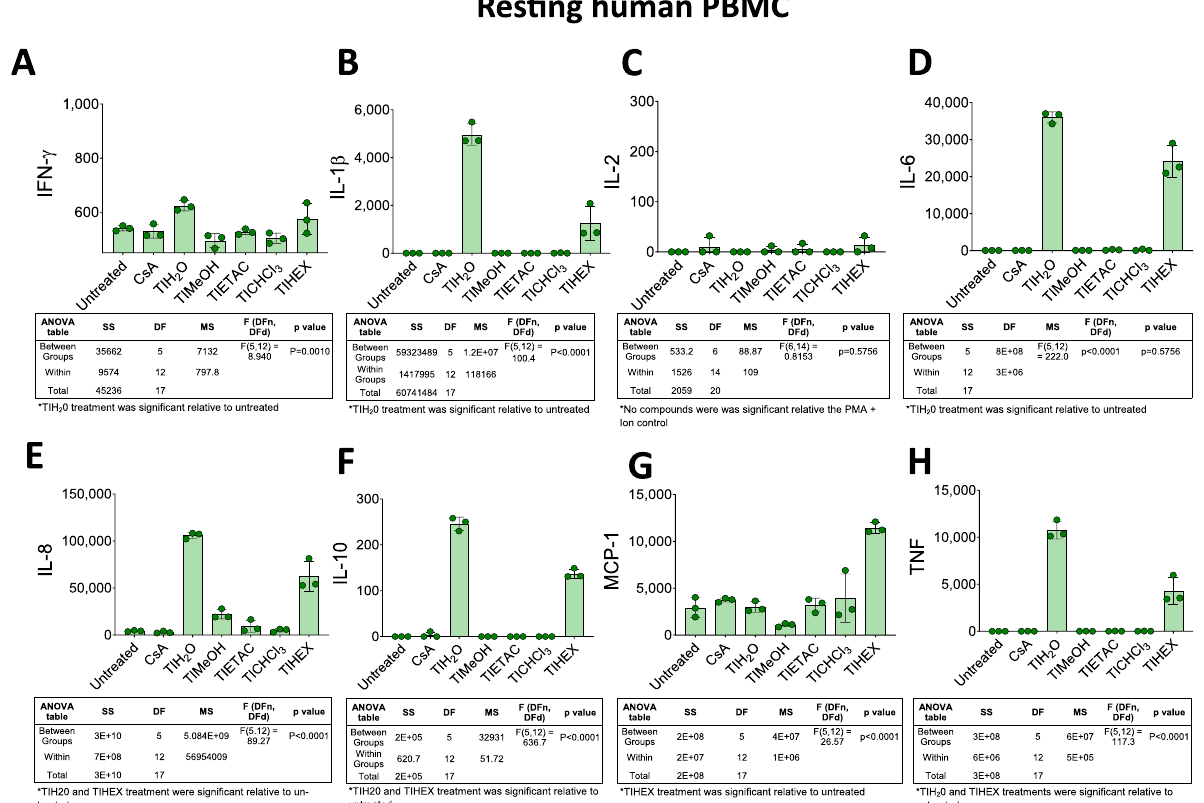
Figure 3. Handroanthus impetiginosus (Mart. ex DC.) Mattos (Bignoniaceae) bark-derived compounds can induce cytokine release at rest. PBMC were combined with TIH 2 O aqueous extracts, TIMeOH methanolic extracts, TIETAC ethyl acetate extracts, TICHCl 3 chloroform extracts and TIHEX hexane extracts for 24 h. Individual cytokine levels of ( A ) IFN-γ, ( B ) IL-1β, ( C ) IL-2, ( D ) IL-6, ( E ) IL-8, ( F ) IL-10, ( G ) MCP-1 and ( H ) TNF were quantified by CBA as detailed in the “Material and methods” section. The data is the mean of three replicates ± SD. Associated ANOVA Tables are presented beneath the line graphs and significant or nonsignificant (*) results are shown beneath the